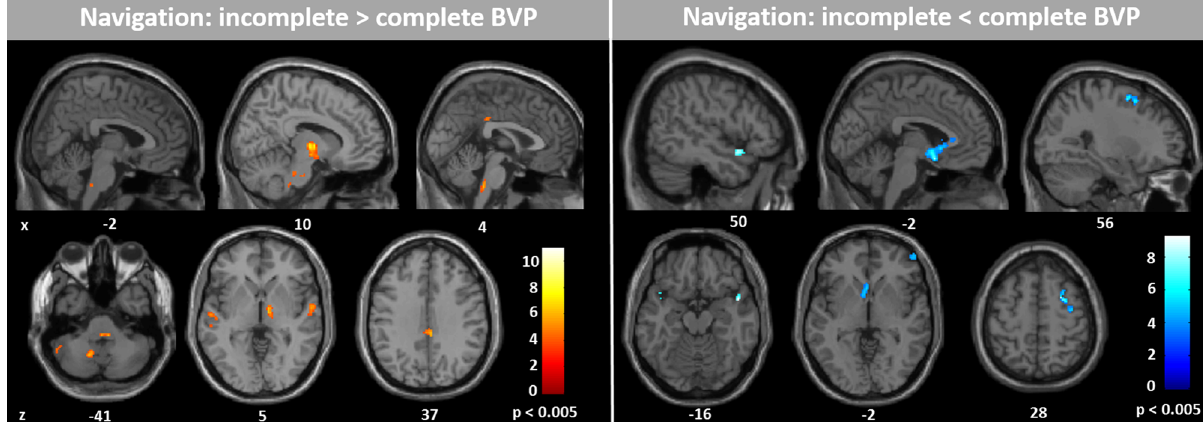
Figure 6. Regional cerebral glucose metabolism (rCGM) during navigation in BVP subgroups. Comparison of rCGM during navigation in patients with complete (mean vHIT gain: 0, mean caloric response: 0 deg/s) and incomplete BVP (mean vHIT gain: 0.4, mean caloric response: 2.2 deg/s) revealed the following: patients with incomplete BVP had higher rCGM in the pontine brainstem tegmentum, vestibulocerebellum (left > right flocculus), anterior thalamus (right > left), and retrosplenial cortex, and lower rCGM in the dorsolateral prefrontal cortex, subgenual prefrontal cortex, superior temporal gyrus, and caudate nucleus. Significance level p < 0.005; colour scale indicates t-score; levels of sections in x- and z-direction are given by MNI coordinates. BVP: bilateral